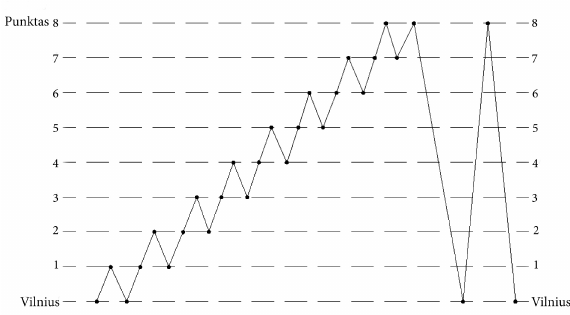
Fig. 3. The scheme of gravimetric